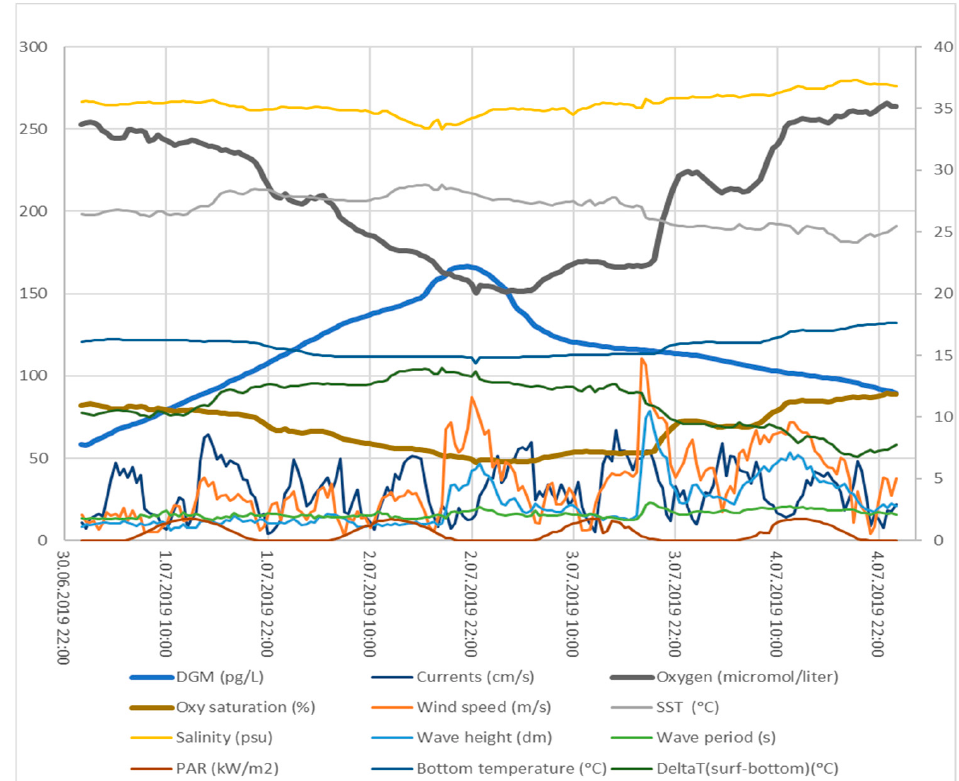
Figure 4. Time series of the observed parameters in the period 1–4 July. The following variables are depicted on the secondary axis: wind and current speed, surface and bottom temperature and the difference between them, wave height and wave period, and PAR and salinity.